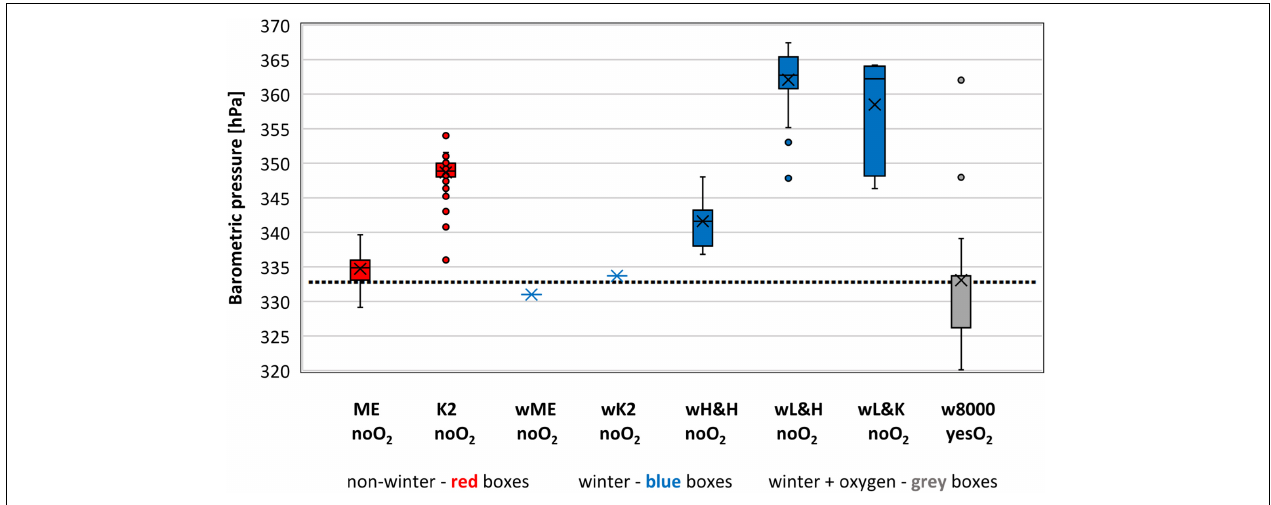
FIGURE 1 | Barometric pressure experienced on the summits we analyzed. Sample size – 499 ascents without oxygen support and 29 with oxygen support (1978–2021). Bars extend to the maximum and minimum BP, boxes span the 25th–75th percentiles, crosses inside the boxes mark mean values, horizontal lines inside the boxes represents median values, dots mark outliers, dotted line represents 10th percentile value of 333 hPa for all 499 ascents with no supplemental